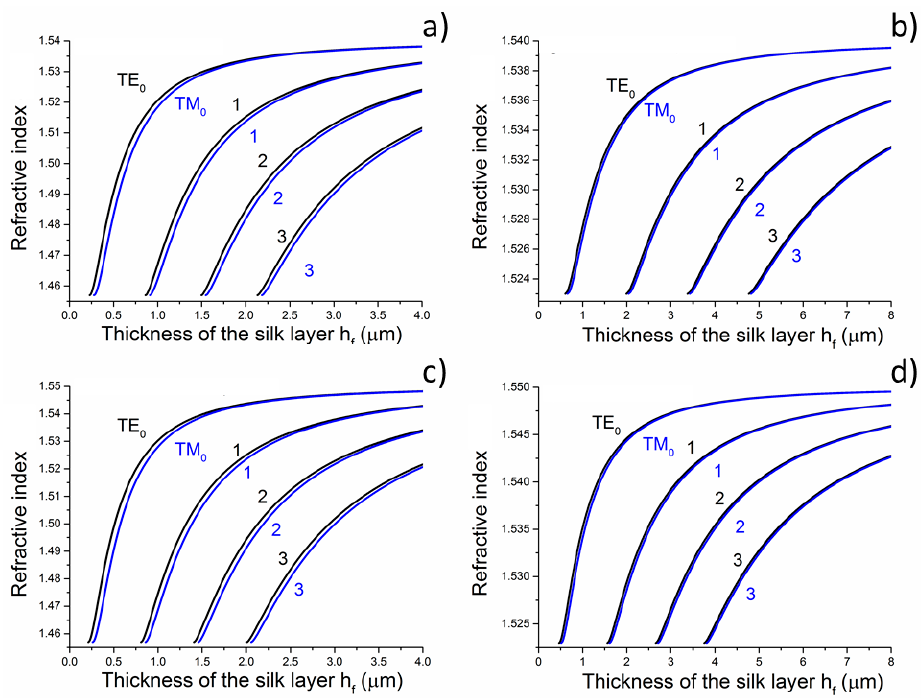
Figure 2. Mode calculations performed for the wavelength of 632.8 nm of the silk optical planar waveguides: ( a ) silk layer ( n f = 1.540) deposited on a Si/SiO 2 substrate; ( b ) silk layer ( n f = 1.540) deposited on a borosilicate glass substrate; ( c ) silk layer ( n f = 1.550) deposited on Si/SiO 2 ; and, ( d ) silk layer ( n f = 1.550) deposited on a borosilicate glass substrate.